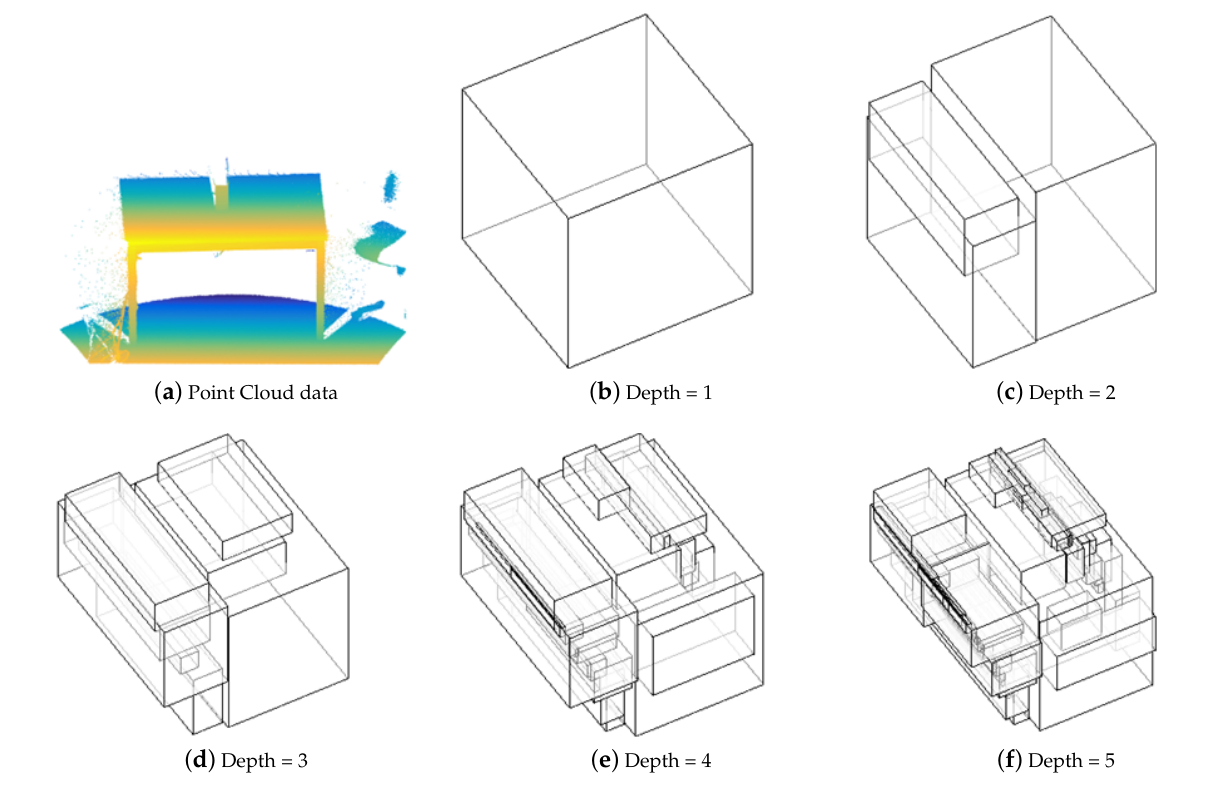
Figure 3. Visualization of 3D